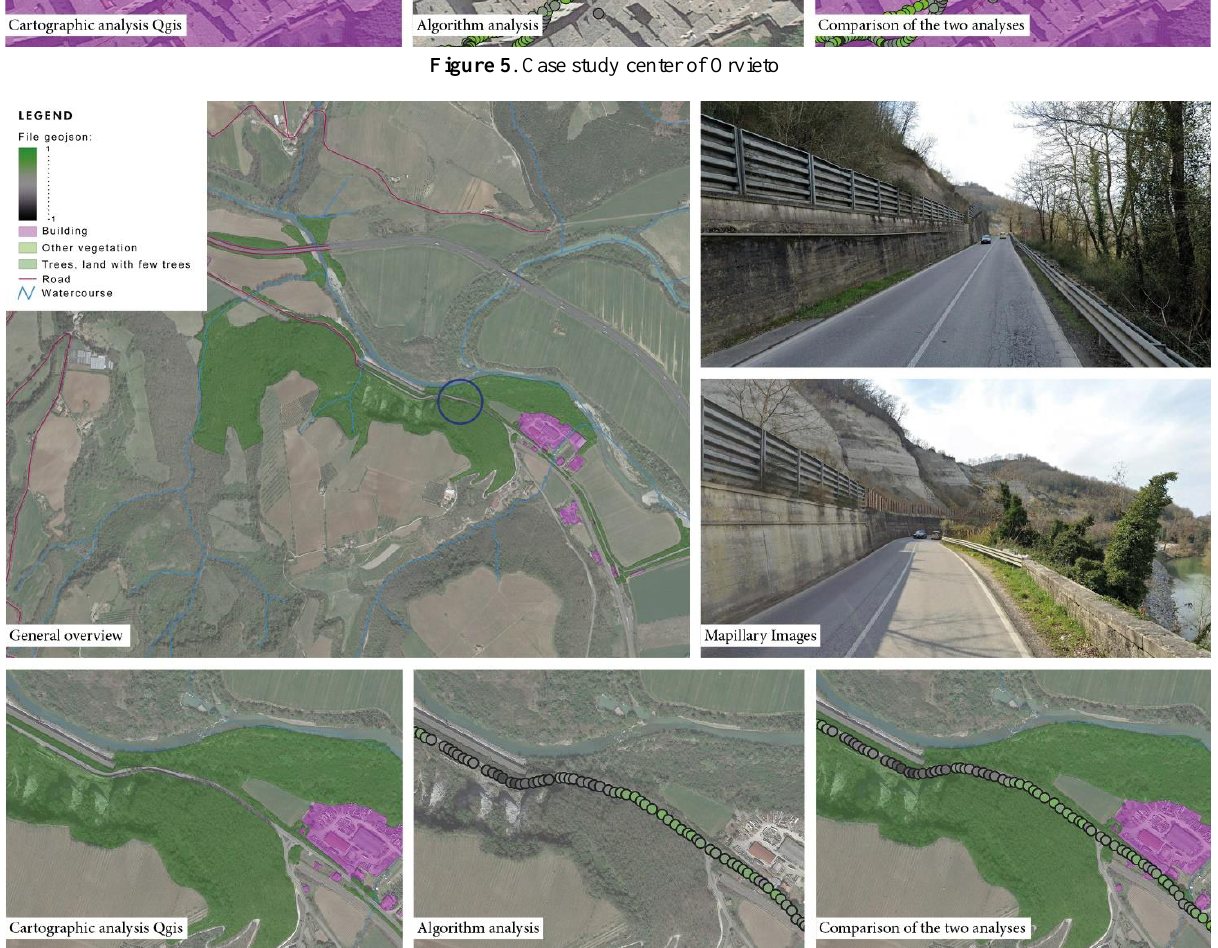
Figure 5 . Case study center of Orvieto